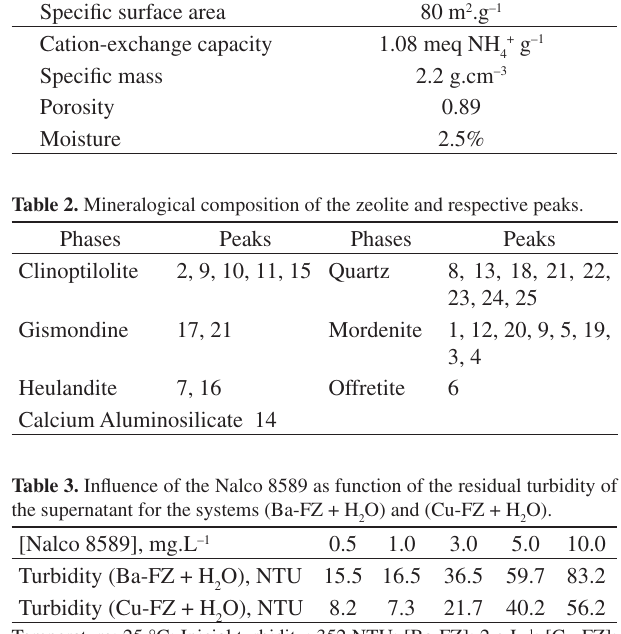
Figure 4. Image of zeolite particles obtained by scanning electron microscopy. Bar length is 50 µ m. and the magnification 631 x .